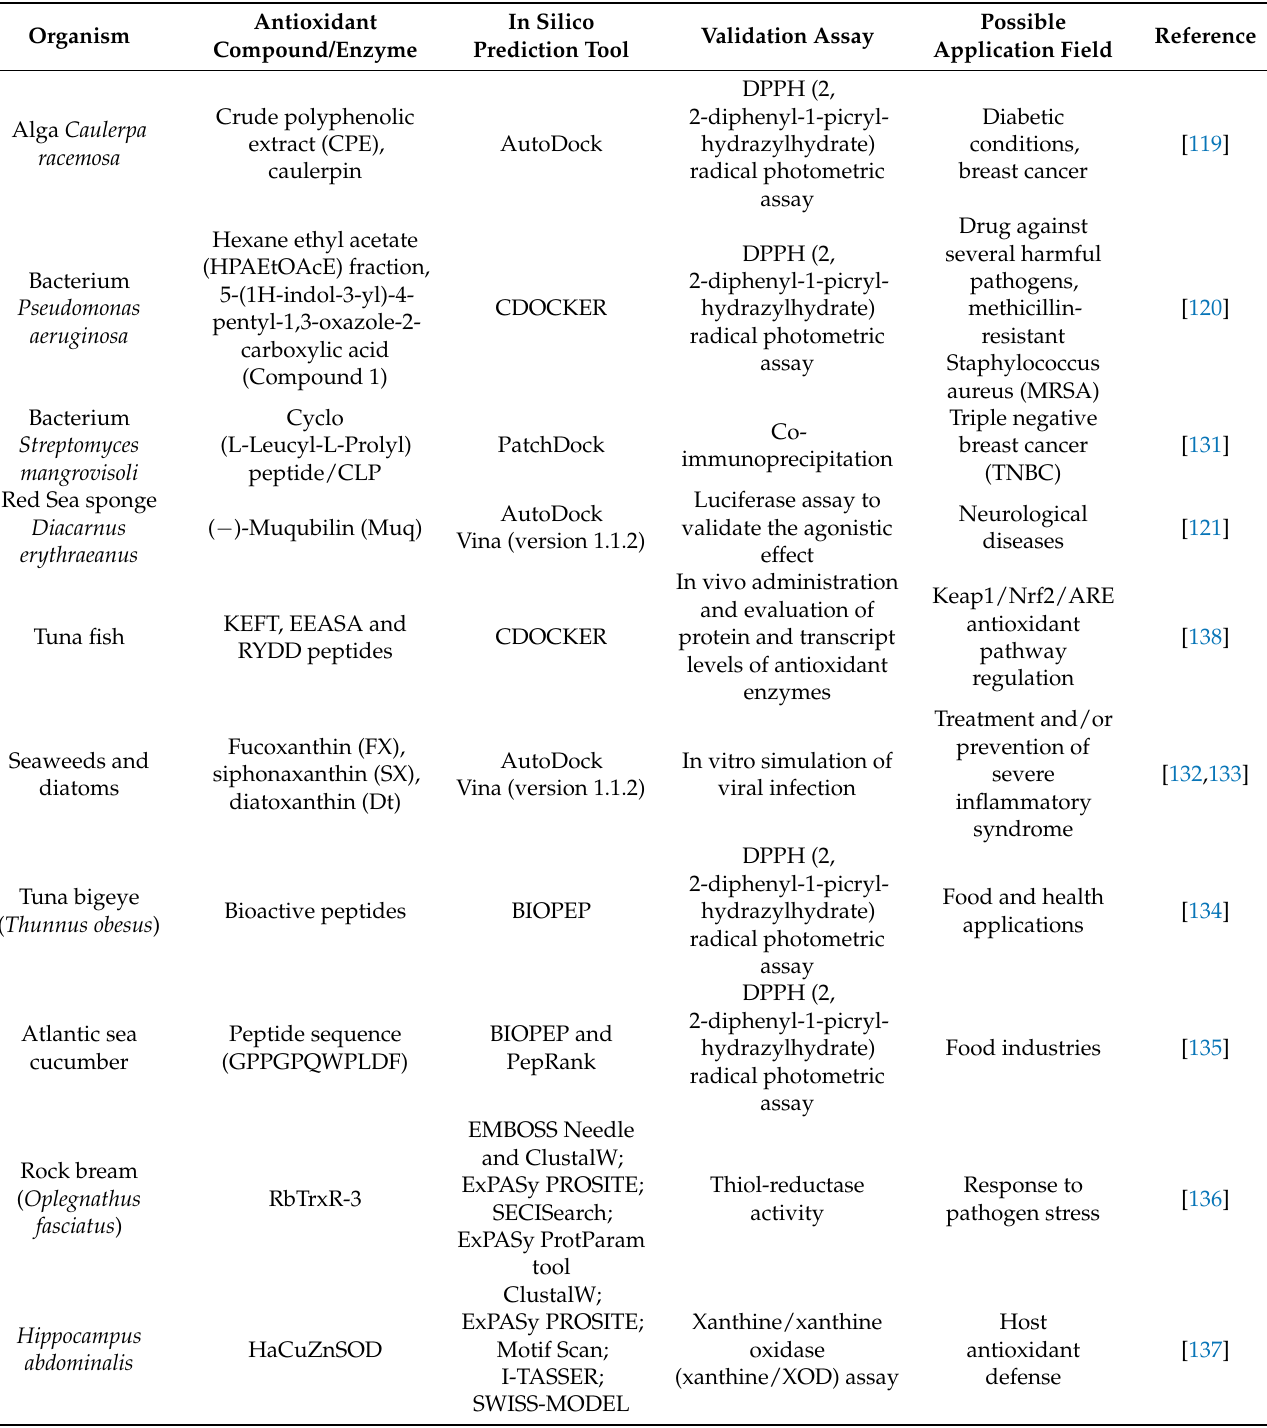
Table 2. Representative examples of in silico analysis and validation to discover antioxidant properties of marine